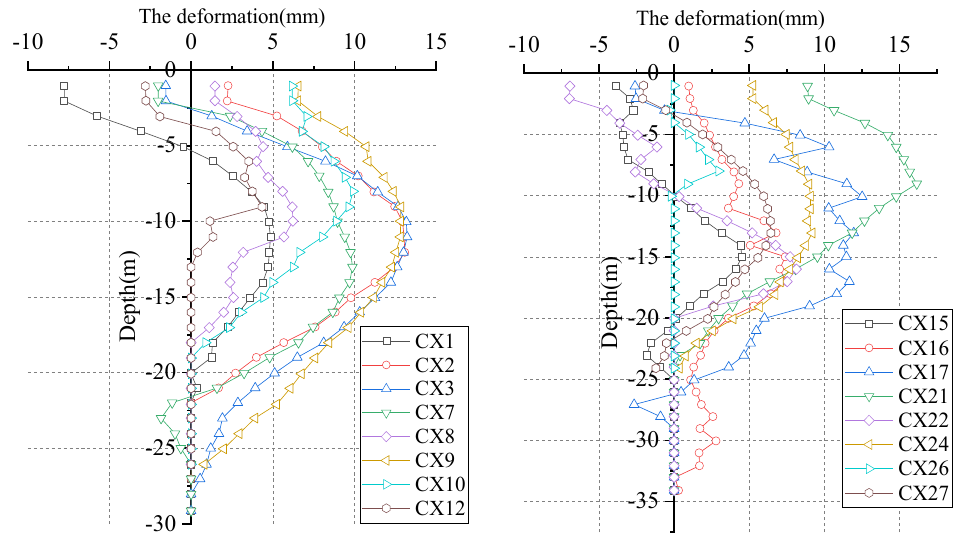
Figure 23. Deep displacement of the retaining structure during bowknot district excavation.